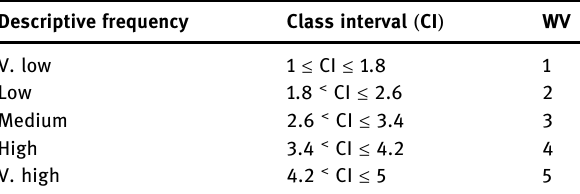
Table 3: Weight value ( WV ) of descriptive frequencies [ 18 ]